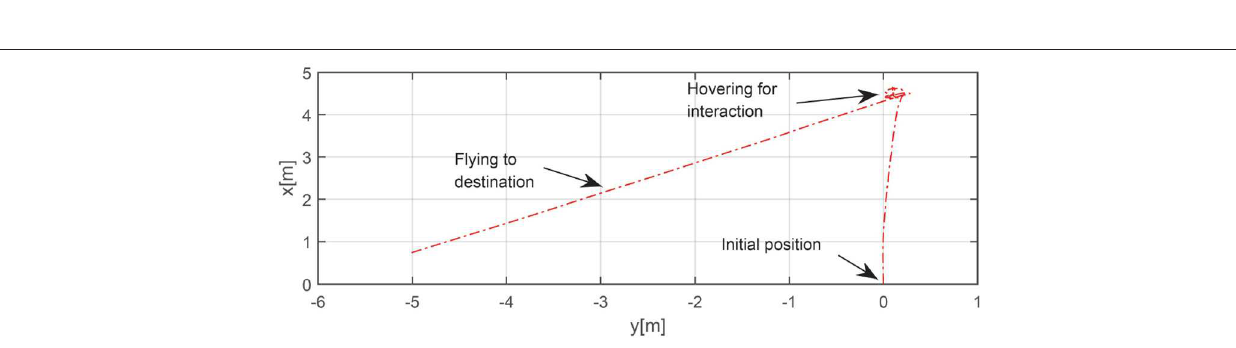
FIGURE 13 | Trajectory in automated exploration